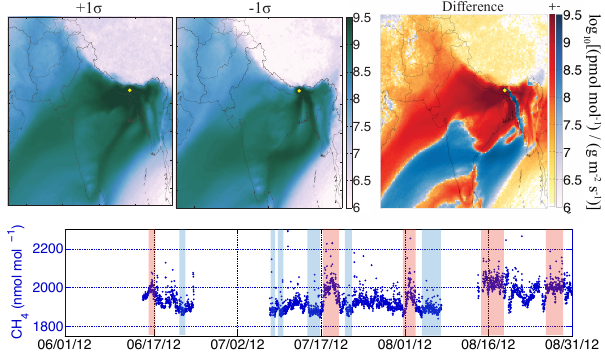
Fig. 6. (Top) Average air histories from Darjeeling (yellow dot) cor- responding to CH 4 measurements from December 2011 through February 2012 that are 1 σ above the mean of the period after smoothing (top, left), measurements that are 1 σ below the mean af- ter smoothing (top, middle) and the difference between the two (top, right). The difference map is shown using two color maps represent- ing the log value of positive and negative differences, respectively. (Bottom) Mole fractions (unsmoothed) from the period are shown with highlighted portions corresponding to the +1 σ (red) and -1 σ (blue) measurements after smoothing.